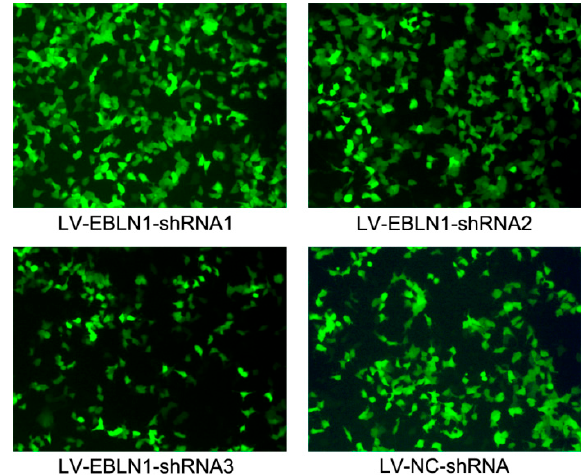
Figure 1. Examination of lentivirus infection efficiencies in oligodendroglia (OL) cells by fluorescence microscopy at 72 h post-infection (100×).